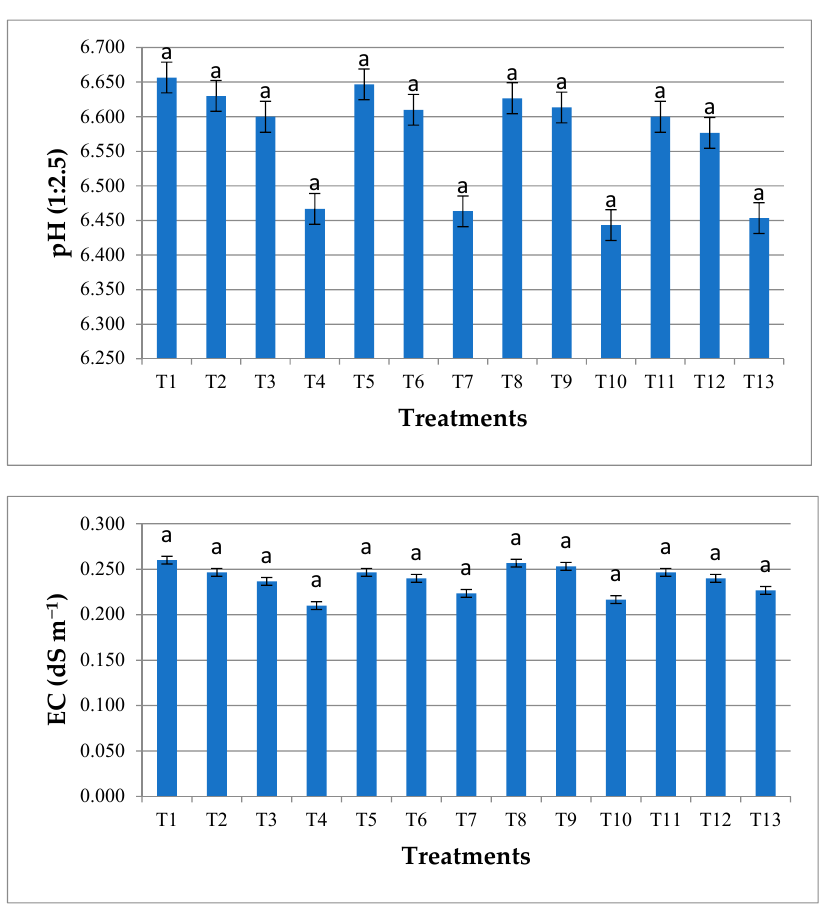
Figure 2. Effect of different treatments on soil pH and electrical conductivity. Mean values exhibiting same letter do not differ significantly ( p < 0.05).